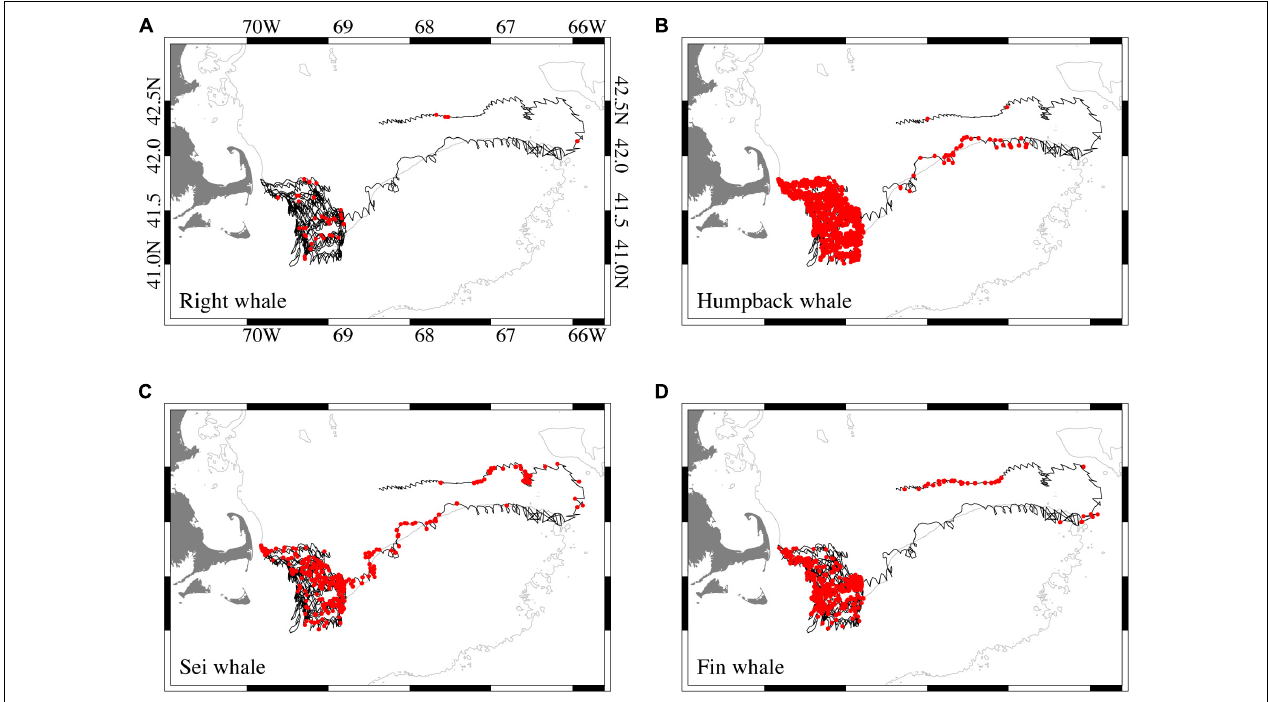
FIGURE 3 | Track of the WHOI Slocum glider during 2015 and 2016 combined (black) and locations of the glider when (A) right, (B) humpback, (C) sei, and (D) fin whales were scored as “detected” (red filled circles). The 50-fathom isobath is shown in gray.